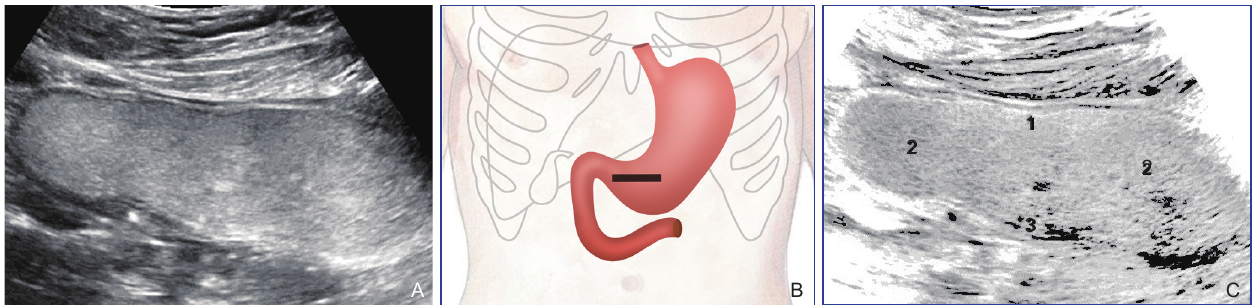
Figure 12 Ultrasonogram and schematic diagram of long axis section of gastric antrum and gastric body (scan of the middle and upper abdomen). A. Ultrasonogram. B. Schematic diagram, C. Schematic diagram of ultrasound (1. Anterior gastric wall; 2. Gastric cavity; 3. Posterior gastric wall)